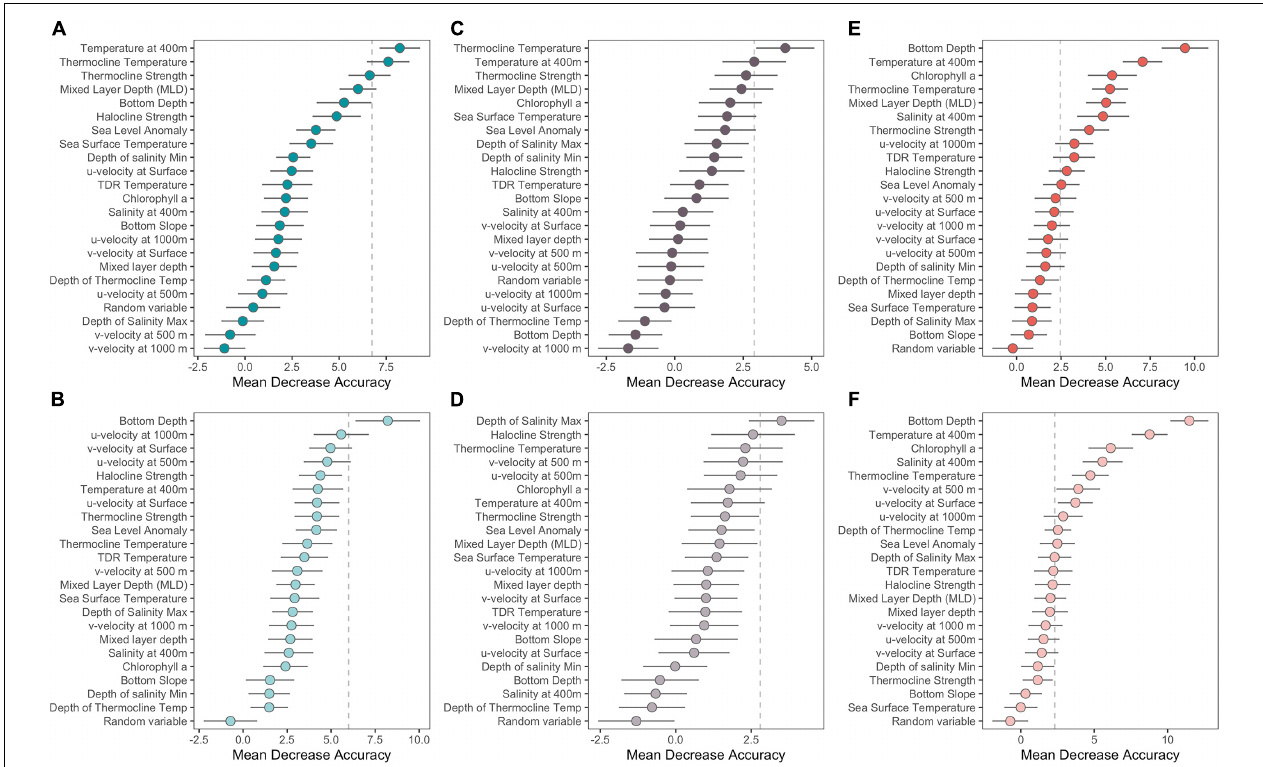
FIGURE 4 | Mean decrease accuracy of each environmental covariate for the three species Ensemble Random Forest models: all species (A,B) , Blainville’s beaked whales (C,D) , and Cuvier’s beaked whales (E,F) , for the full study area (A,C,E) and north only (B,D,F) . Mean decrease accuracy is a measure of how much removing each covariate reduces the accuracy of the model. Covariates to the right of the dashed gray bar represent those where more than 5% of the total number of whale encounters are omitted when that covariate is excluded for that particular